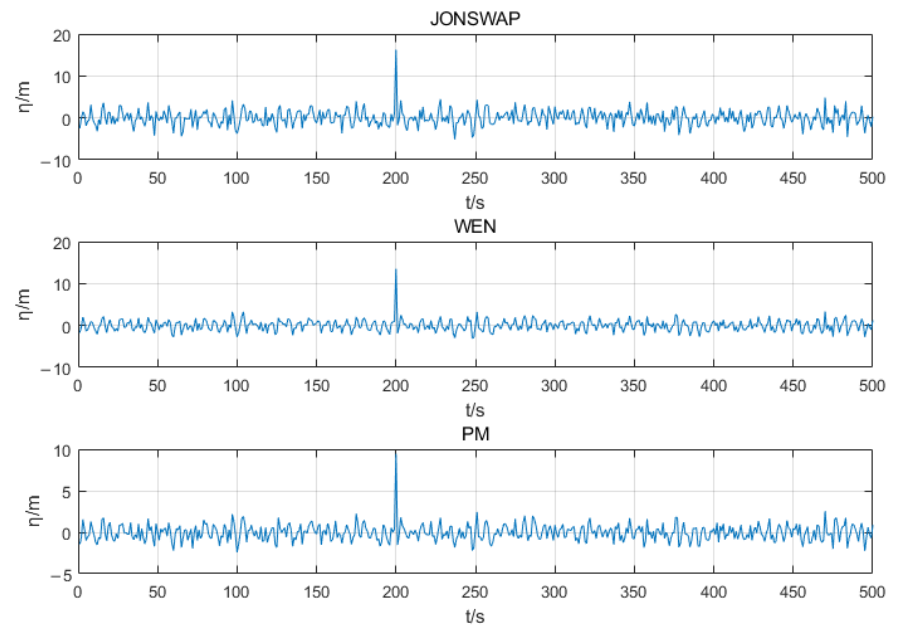
Figure 4. JONSWAP spectrum simulation freak wave time series, Wen’s spectrum simulation freak wave time series, and PM spectrum simulation freak wave time series based on phase modulation method. Table 3. Characteristic parameter values of freak waves of three kinds of wave spectra. a1 a2 a3 a4 S JONSWAP 2.8811 WEN PM